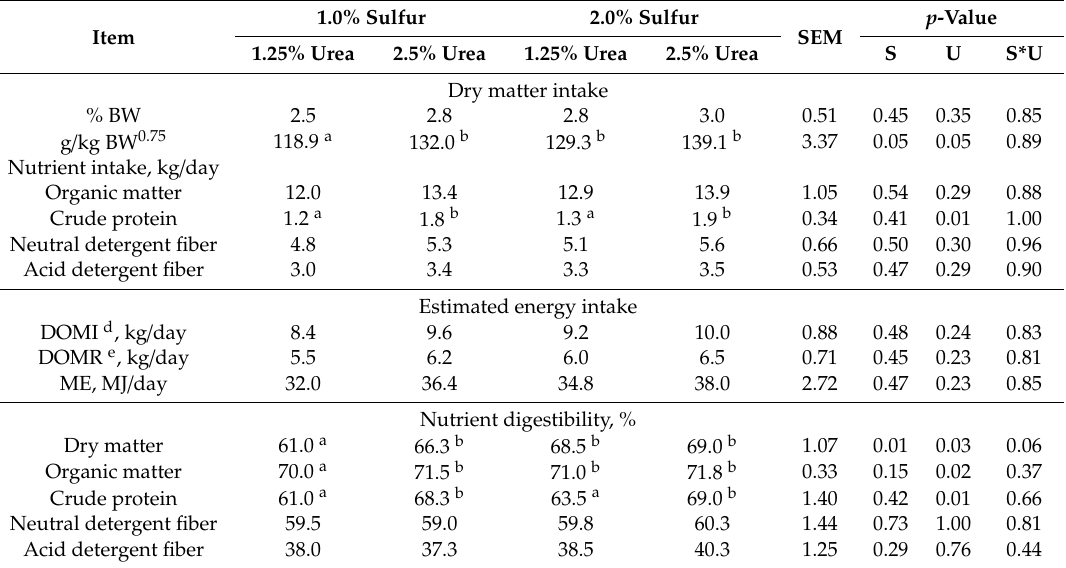
Table 2. Influence of fermented total mixed ration on dry matter intake, nutrient intake and digestibility coe ffi cients in dairy